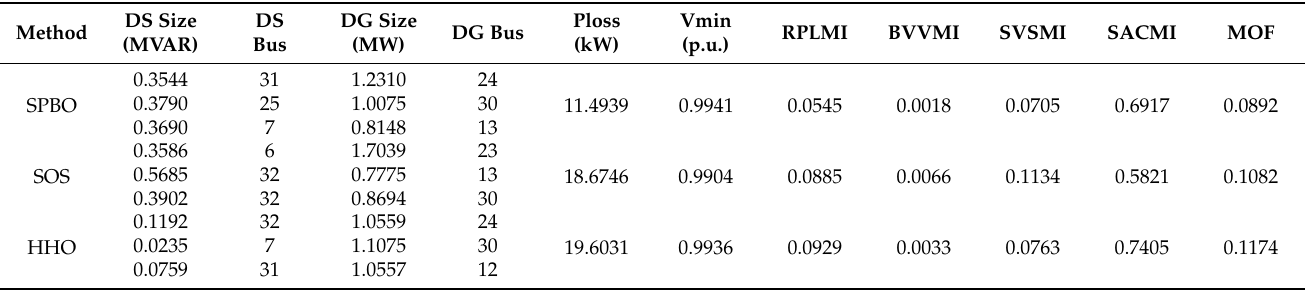
Table 15. Comparison of results for simultaneous DS and 1 PV-DG and 2 GT-DG allocation (case-8) for 33-bus test system.